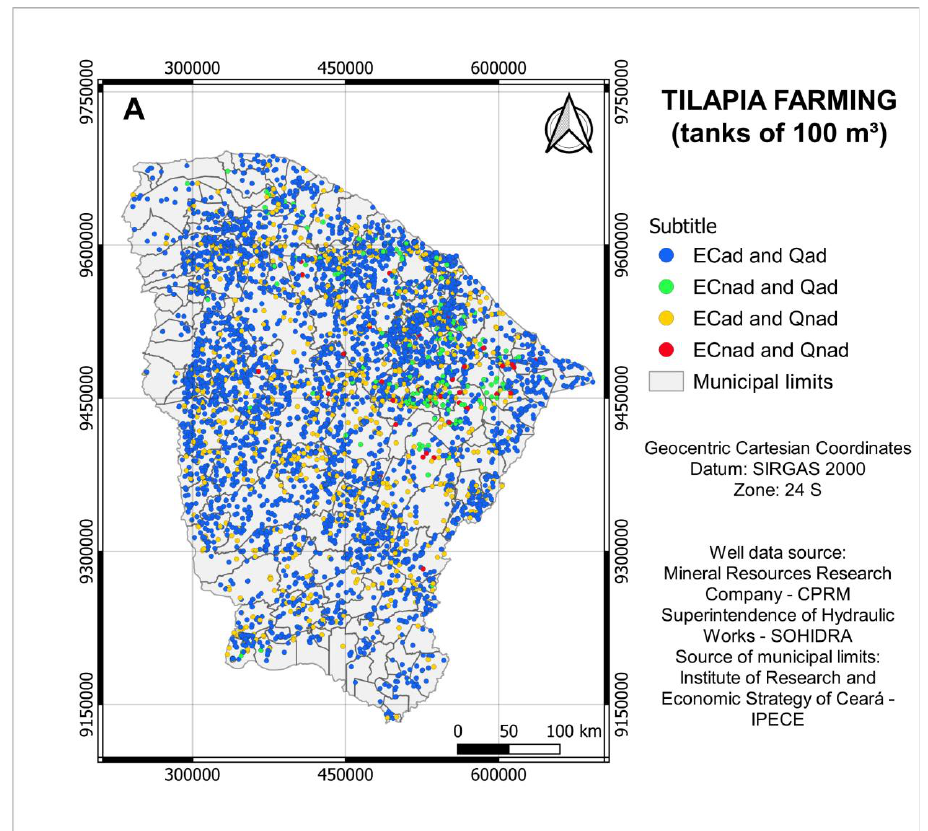
Figure 9. Potential of brackish groundwater in the State of Ceará (Northeast Brazil) for raising tilapia in tanks with a total volume of 100 m 3 , based on the threshold electrical conductivity of the irrigation water (EC) and discharge rate (Q). EC ad : adequate electrical conductivity; EC nad : inadequate electrical conductivity; Q ad : adequate discharge; Q nad : inadequate Table 5 summarizes all the data on the number of wells with respective suitability categories for the different biosaline systems evaluated. Table 5. Number and percentage of wells for the productive systems tested and considering the different suitability criteria.